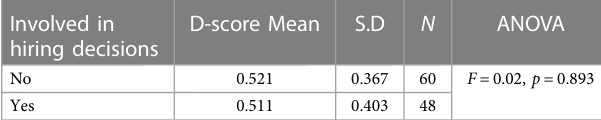
TABLE 4 Effect of being involved in recruitment and/or retention decisions on disability IAT score ( N =108). Involved in hiring decisions